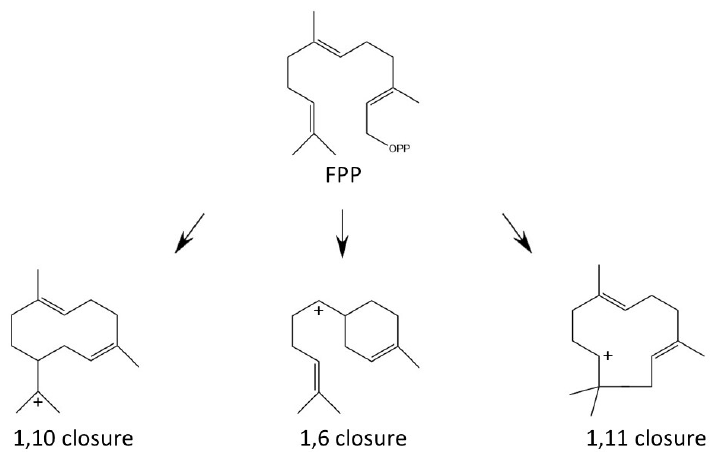
Scheme 1 . Initial cyclization reactions of STS. FPP: farnesyl diphosphate.